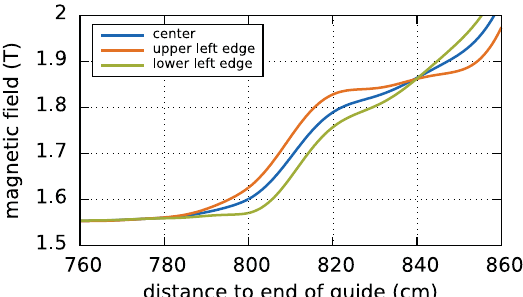
Figure 3. Magnetic field strength along the central field line, for different values of B 1 between 3 and 6T, and B 0 = 1 . 5T and B 2 = 0 . 5 T fixed.